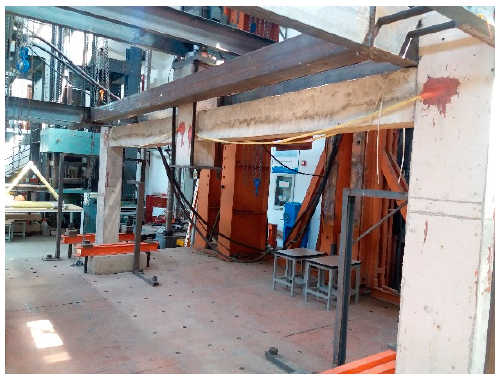
Figure 6. Specimen ICS.